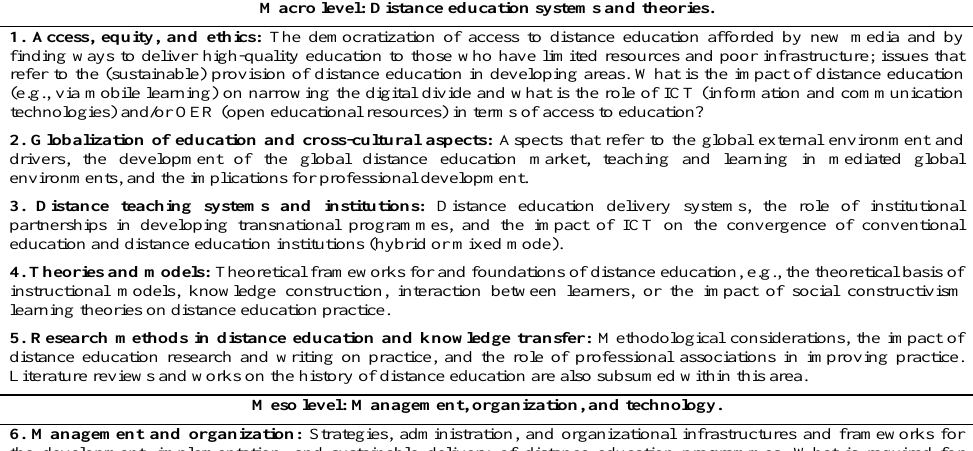
Classification of Research Areas in Distance Education (Zawacki-Richter et al., 2009) Macro level: Distance education systems and